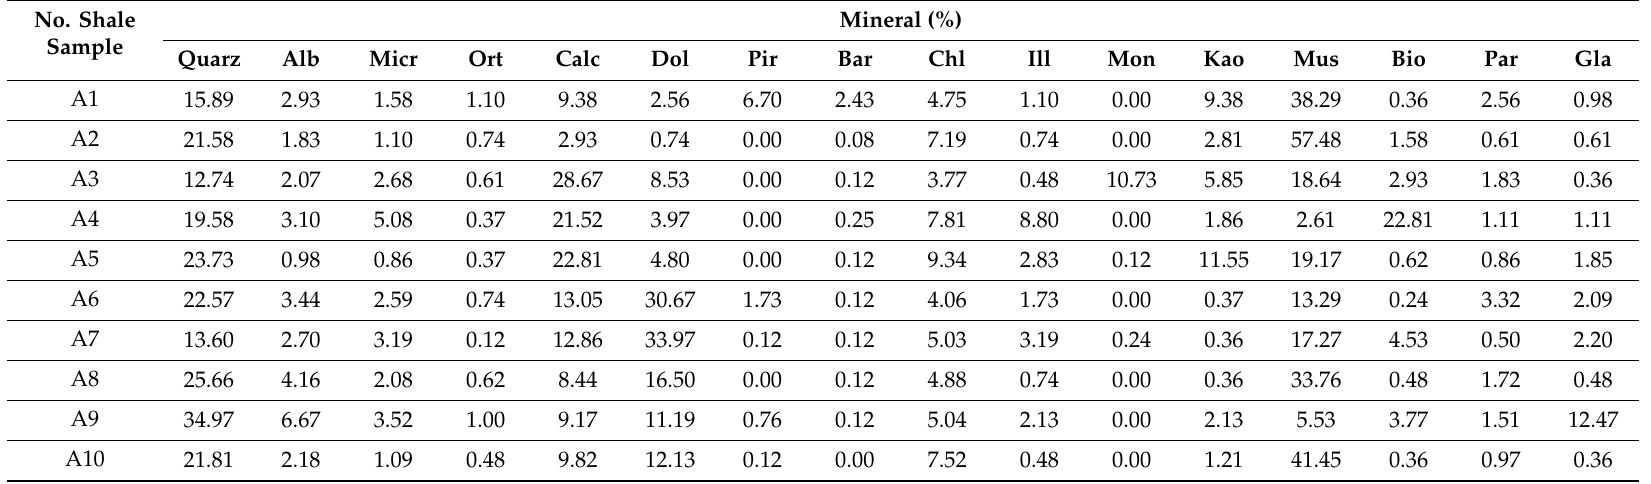
Table A1. Detailed results of XRD analysis of shales